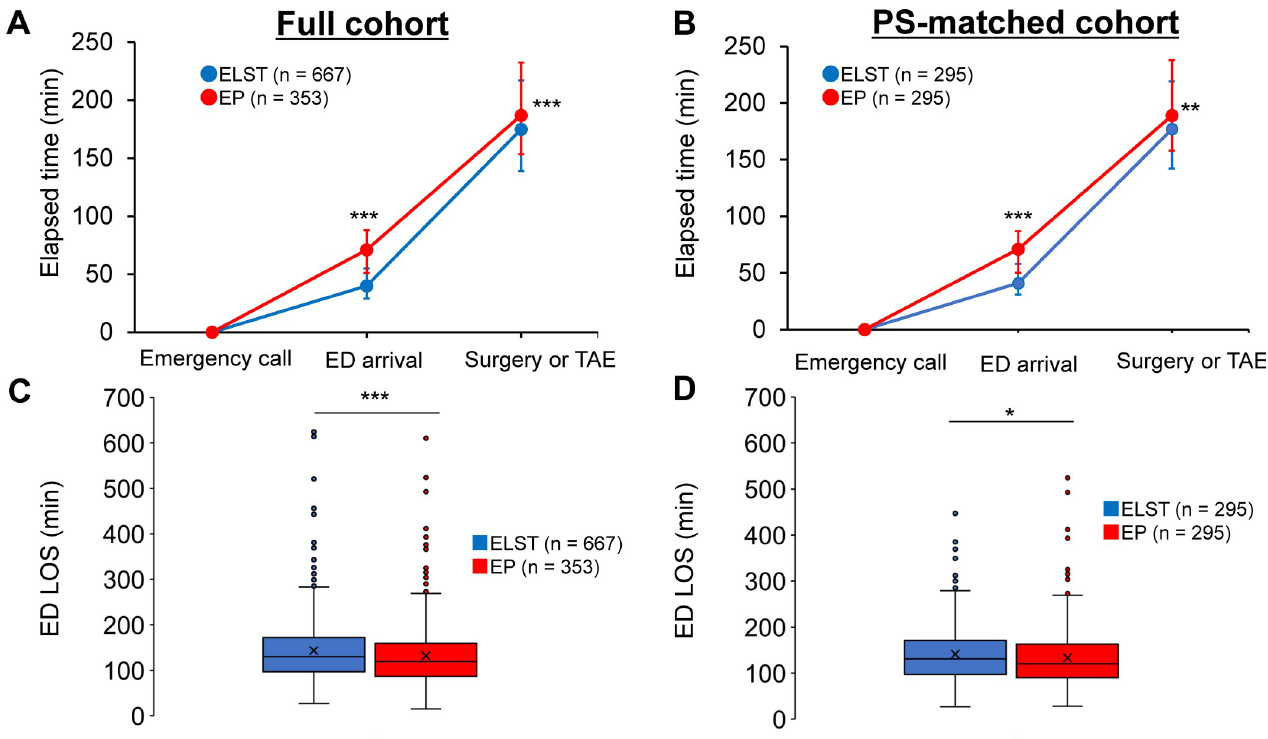
Fig 2. Preoperative time course in injured patients requiring emergency surgery or TAE: EP-staffed vs. ELST-staffed ambulance. Elapsed time from emergency call to ED arrival and arrival in the operating room or catheterization laboratory in the full cohort (A) and PS-matched cohort (B) . Circles represent the median, and error bars represent the 25th and 75th percentiles. Box plots of ED LOS in the full (C) and PS-matched (D) cohorts. ED LOS is defined as time from ED arrival to operating room or catheterization laboratory arrival. Solid line inside the box represents the median, x represents the mean, the box represents the 25th and 75th percentiles, the whiskers represent the lower and upper extremes, and the circles represent outliers. ��� P < 0.001, �� P < 0.01, and � P < 0.05 using the Mann–Whitney U test. ED, emergency department; ELST, emergency life-saving technician; EP, emergency physician; LOS, length of stay; TAE, transcatheter arterial